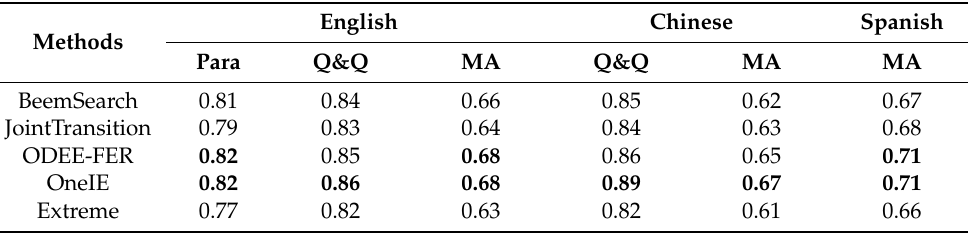
Table 2. The results of our calculation obtained on the condition that the event connection graph is constructed via several popular event extraction methods (highest values in